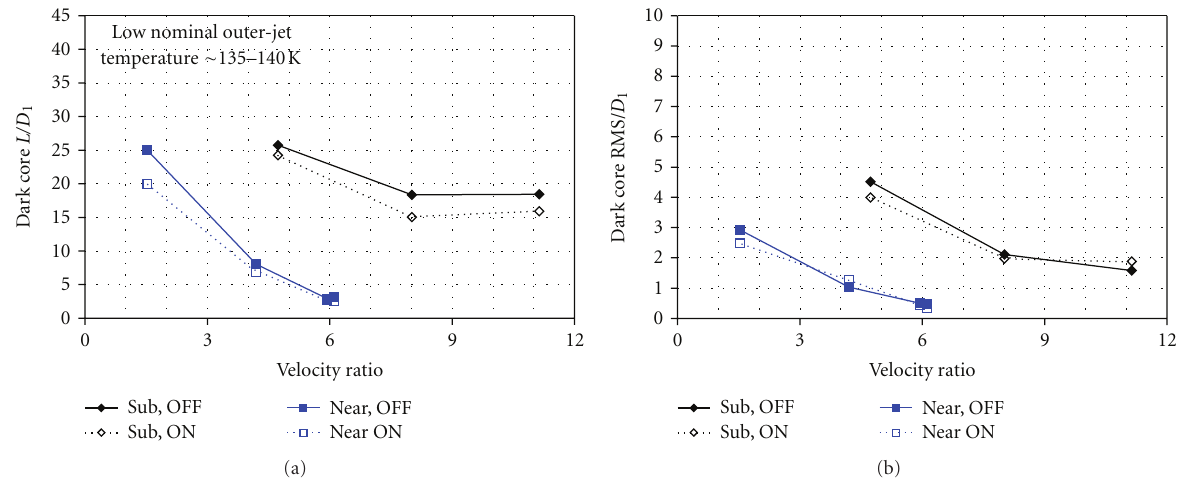
Figure 24: Plot of the averaged dark-core length (a) and the root mean square (RMS) of the length variations (b) normalized by the inner diameter of a LN 2 /GN 2 coaxial jets injector. The solid symbols and lines represent data when the acoustic driver is o ff , and the hollow symbols and dotted lines show results when the acoustic driver is operated at ∼ 3kHz. The diamond and square symbols are for sub- and near-critical chamber pressures, respectively. All cases are for the low nominal outer-jet temperature of ∼ 140 K. In the inset, the words sub and near refer to subcritical and near-critical chamber pressures, respectively, and the words OFF and ON refer to the acoustic driver being o ff and on at ∼ 3kHz, respectively. Davis and Chehroudi [42,